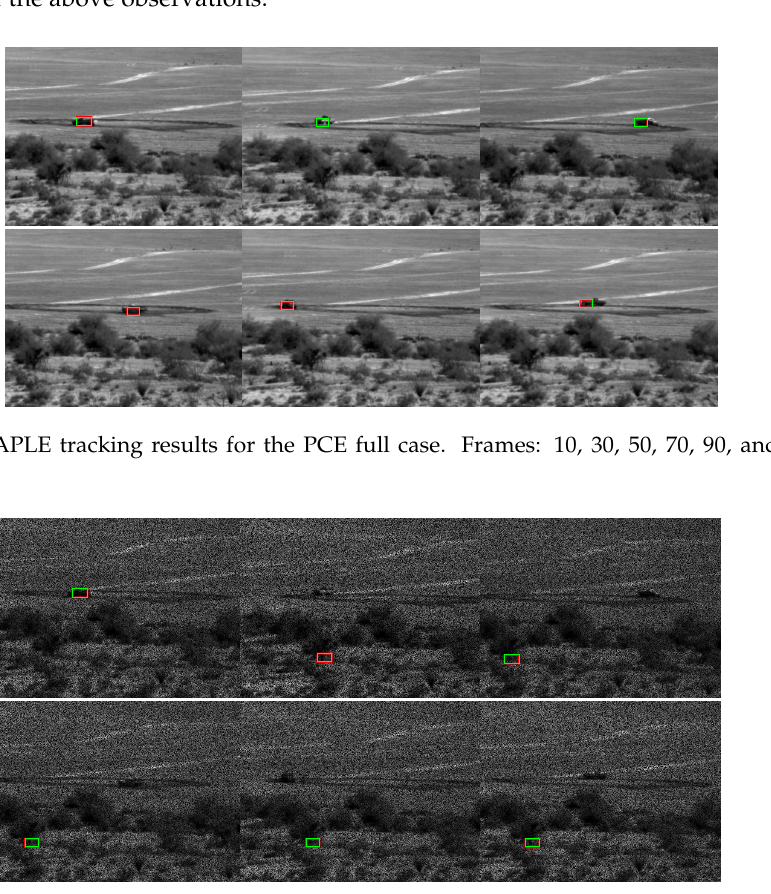
Figure 7. STAPLE tracking results for the PCE 50% case. Frames: 10, 30, 50, 70, 90, and 110 are shown here. The green boxes are not on targets.